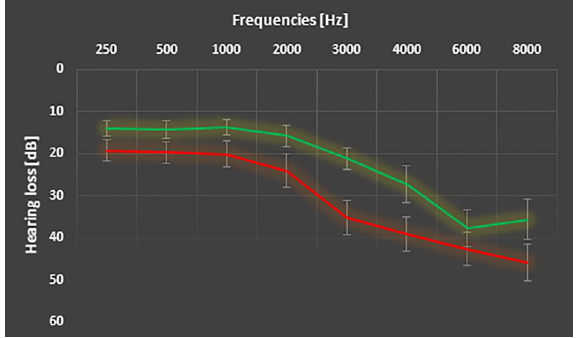
Figure 4. Average pure-tone audiograms for tinnitus patients (red) and control subjects (green) averaged over both ears. Error bars denote standard error of the